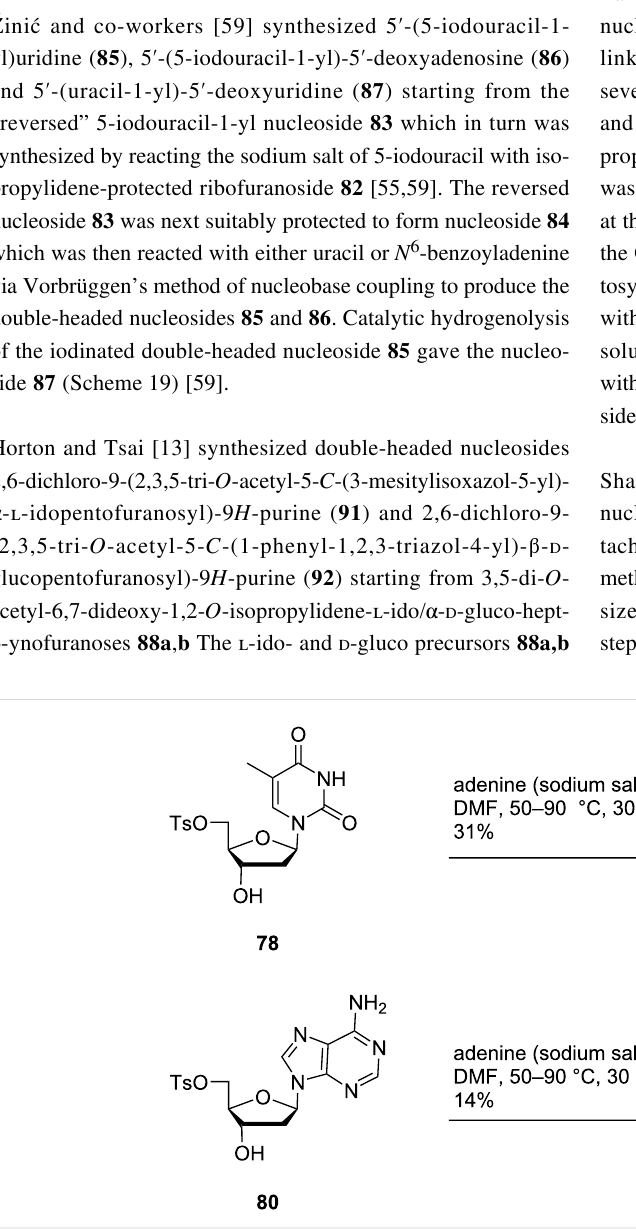
Scheme 18: Synthesis of double-headed nucleosides 5 ′ -(adenine-9-yl)-5 ′ -deoxythymidine ( 79 ) and 5 ′ -(adenine-9-yl)-2 ′ ,5 ′ -dideoxyadenosine ( 81